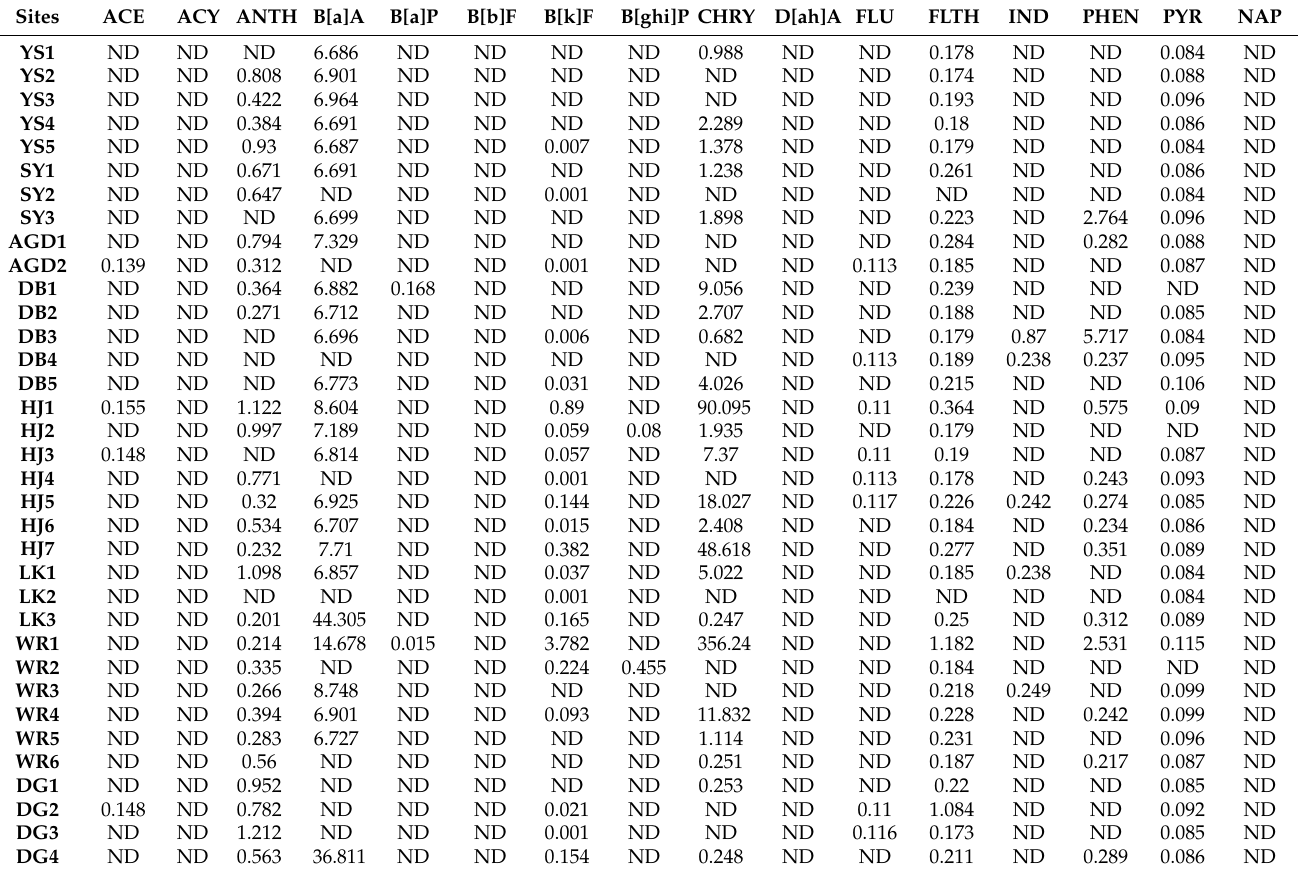
Table 4. Concentrations of 16 PAHs in sediment